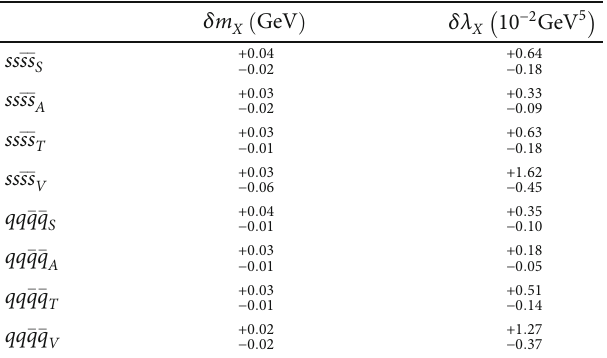
Table 2: The possible uncertainties induced by the perturbative O Þ corrections, where the subscripts S , A , T , and V denote the ð α s scalar, axialvector, tensor, and vector tetraquark states,